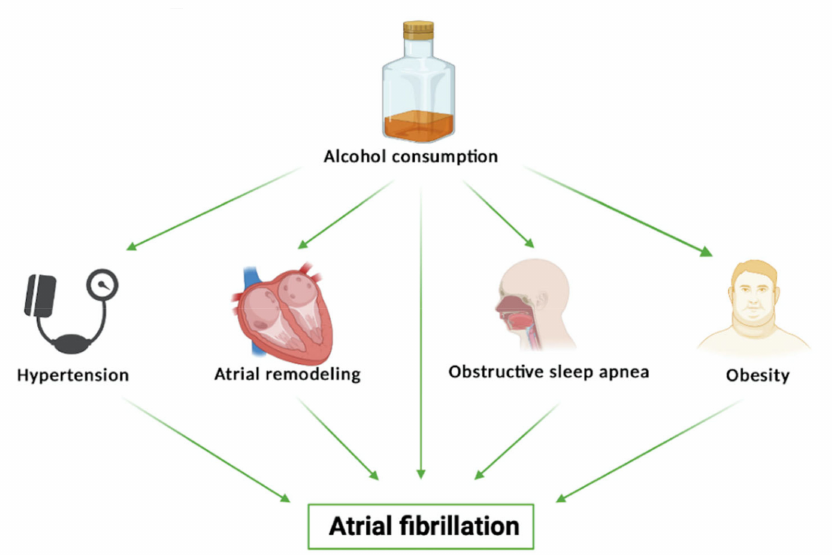
Figure 2. The pathophysiology of alcohol-related atrial